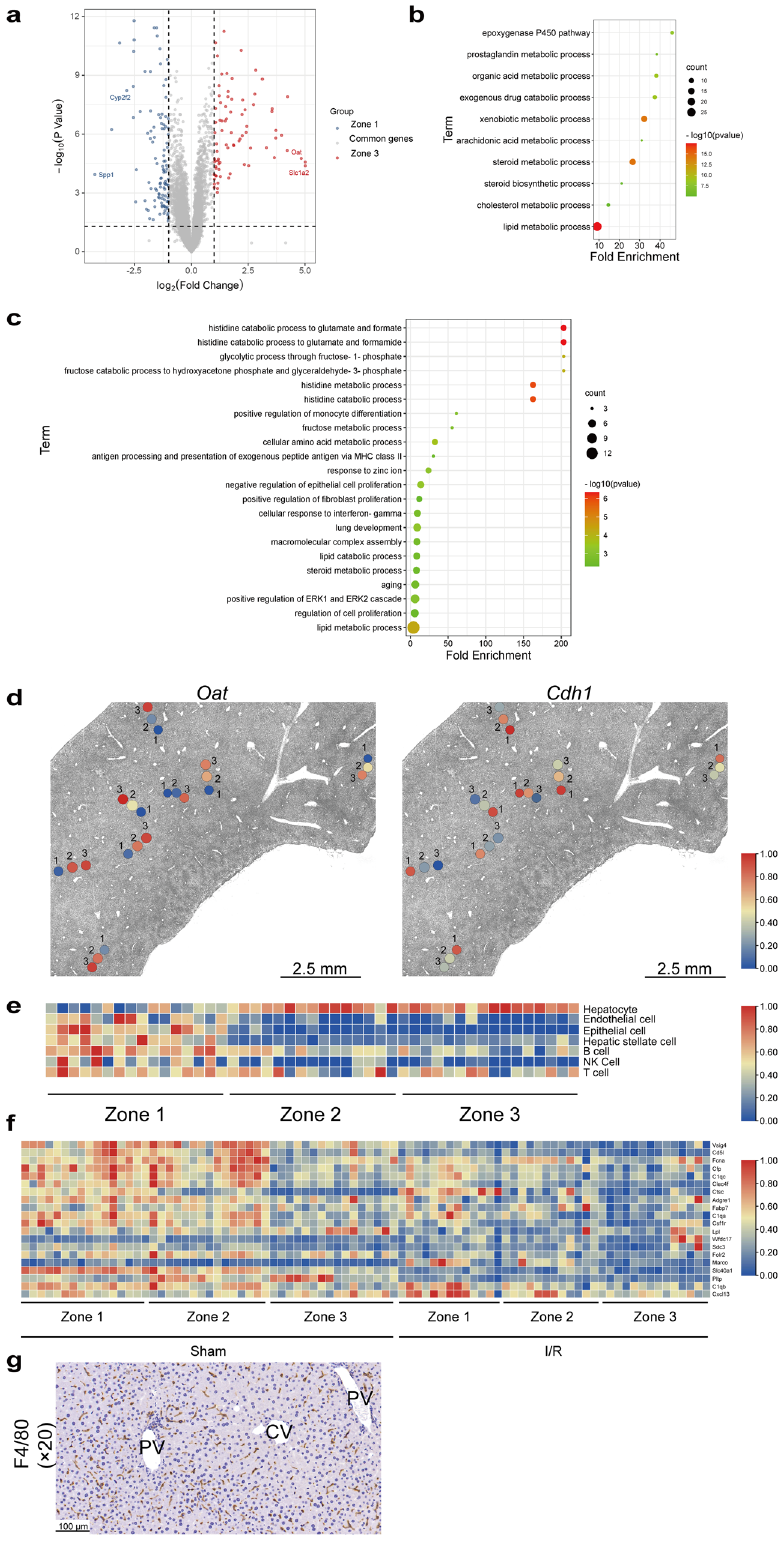
Fig. 2 Spatial transcriptomics analysis of lobule zone-speci fi c genes and functional pathways. a Hepatic zone-speci fi c DEGs at the steady state. b GO analysis of zone 3-speci fi c DEGs. c GO analysis of zone 1-speci fi c DEGs. d In situ plotting of zone-speci fi c genes in the sham group. e Hepatic NPCs and hepatocytes proportion at the steady state. f Heatmap of the top 20 KCs marker genes expression. g IHC result of Kupffer cell marker F4/80.